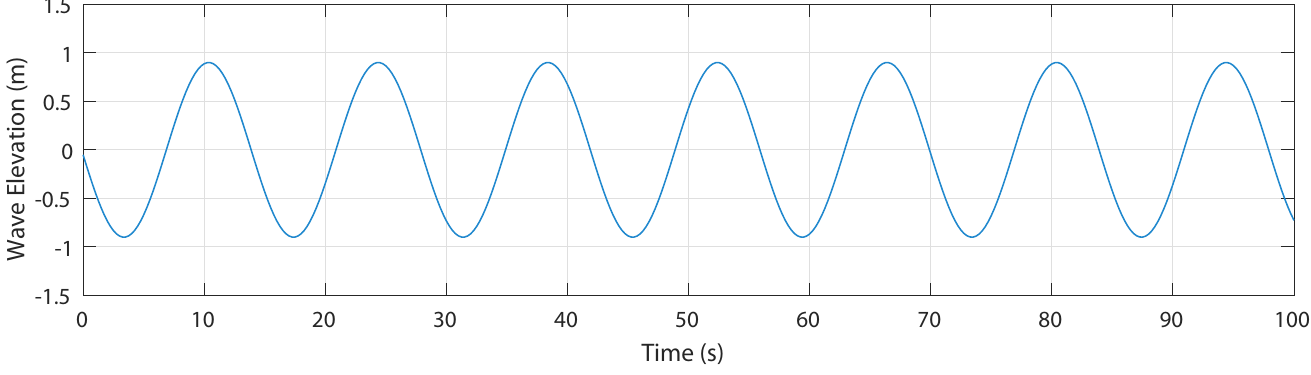
Figure 11. Wave elevation